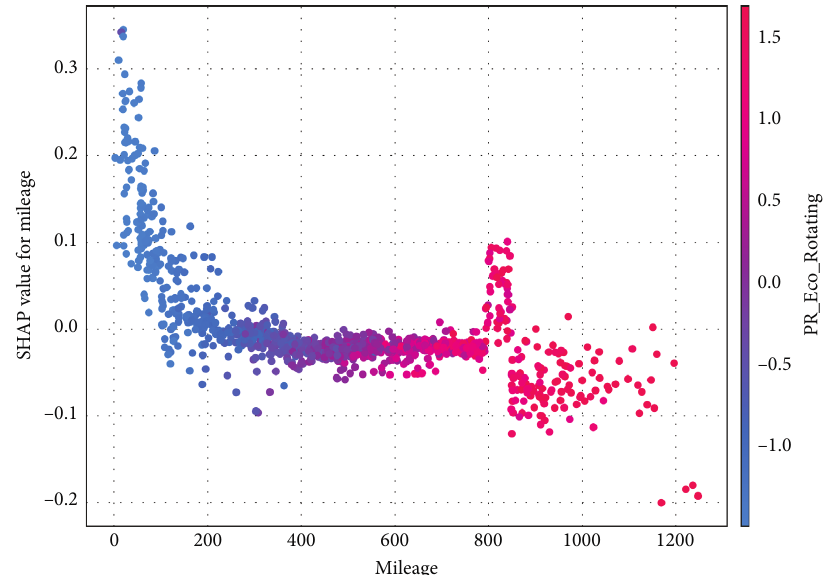
Figure 12: The global impact of mileage on fuel consumption.